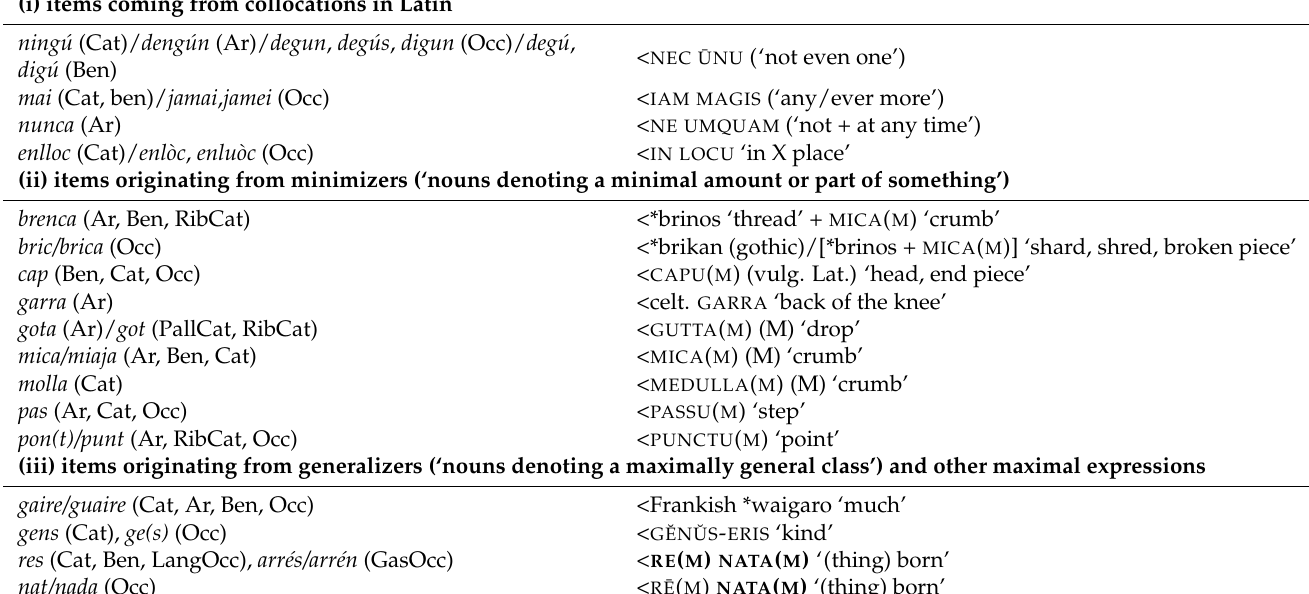
Table A1. The etymology of polar items in Catalan and other trans-Pyrenean Romance